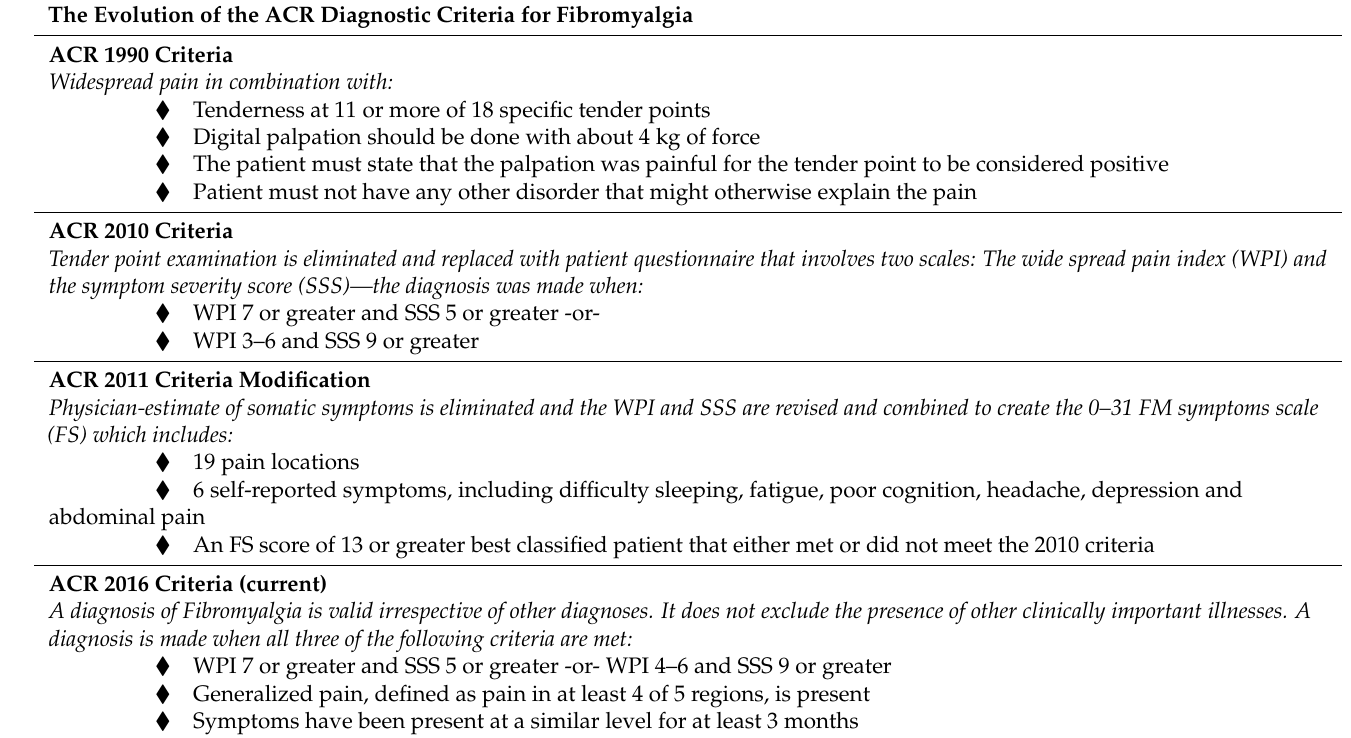
Table 5. Summary of ACR Fibromyalgia diagnostic criteria